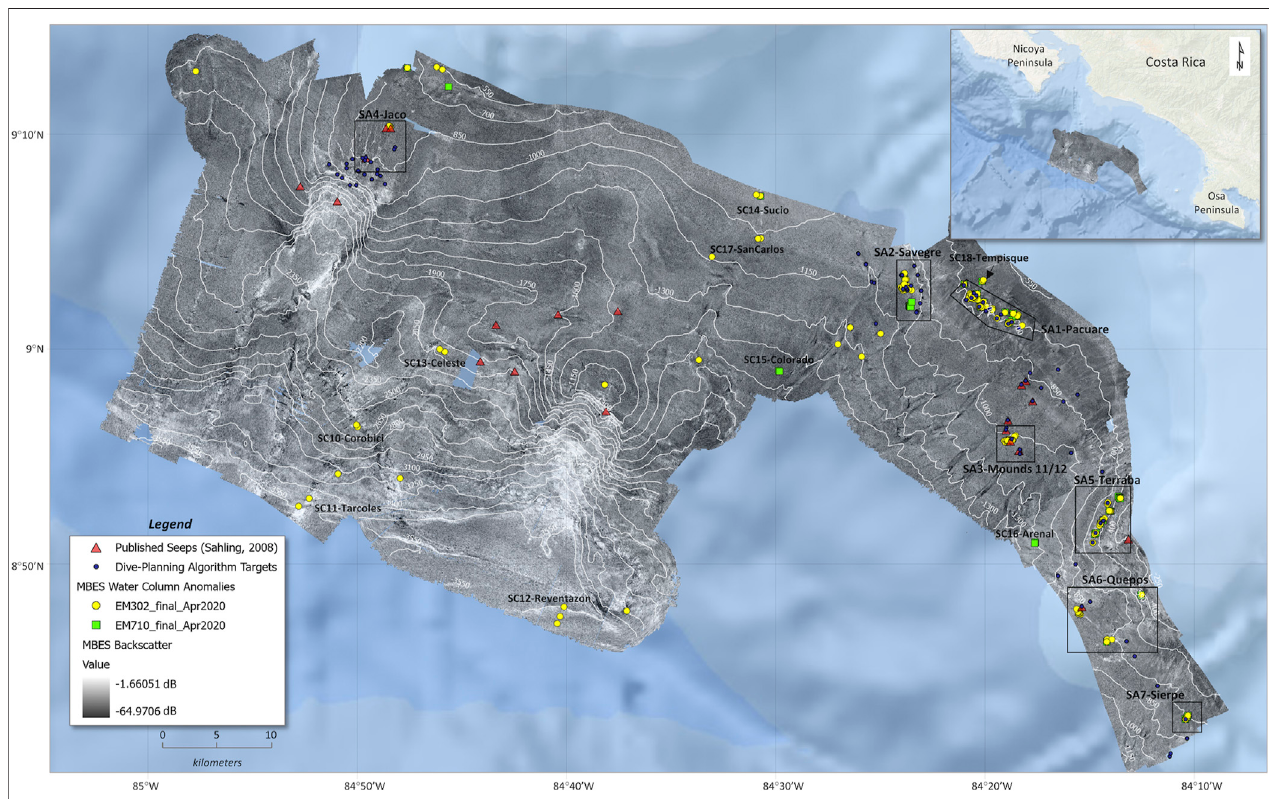
FIGURE 1 | Multibeam backscatter and bathymetry contours (meters) of full study area. Map records MBES water column anomalies identi fi ed in this study, previouslypublishedseeplocations(Sahlingetal.,2008),andtargetsidenti fi edbySpockforinvestigationduringtheexpedition.Mapshowsunevendistributionofwater- column anomalies with depth as well as tendency to occur in clusters. Many anomalies found in areas of previously identi fi ed seeps, but new locations of seepage are also observed. Seep Clusters (SC) and Arrays (SA), de fi ned to re fl ect hierarchy in organization of seep features, are labeled with Costa Rican river names for purposes of